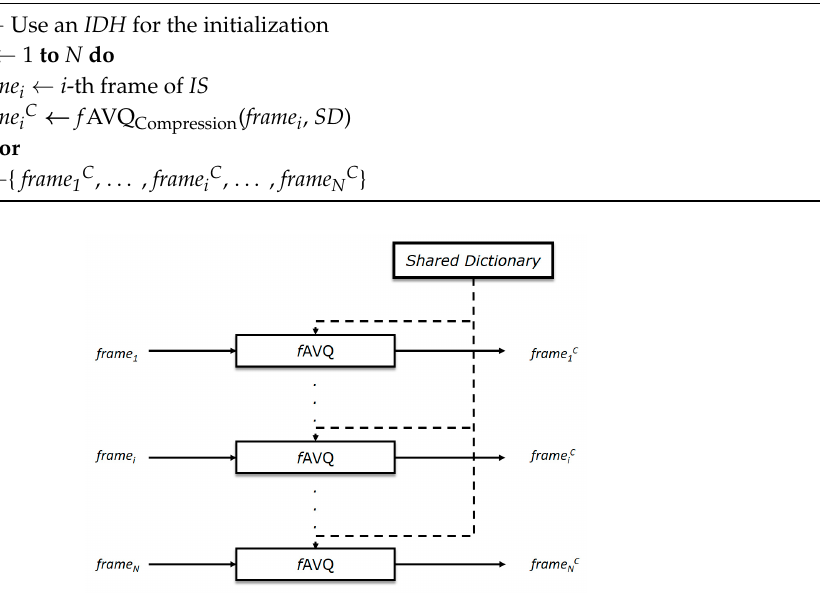
Figure 8. The shared dictionary used by each one of the fAVQ instances.